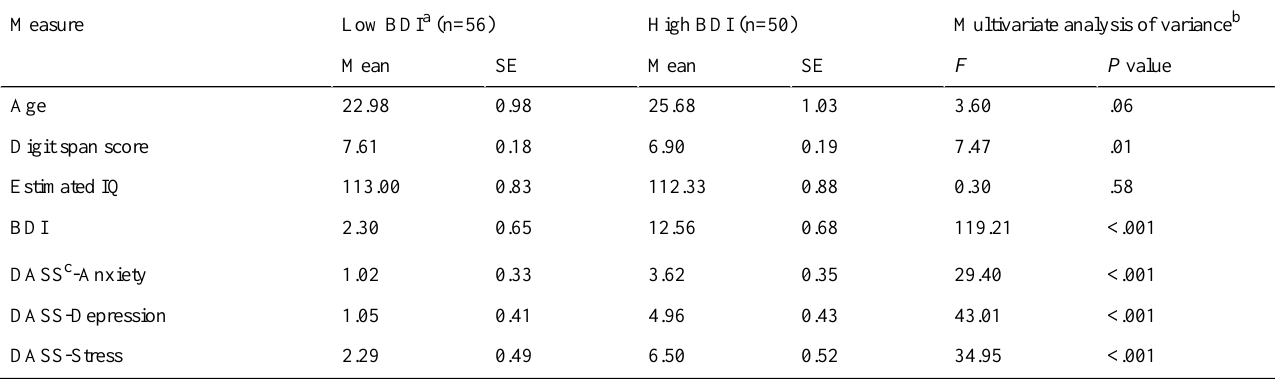
Table 1. Participant characteristics for each BDI